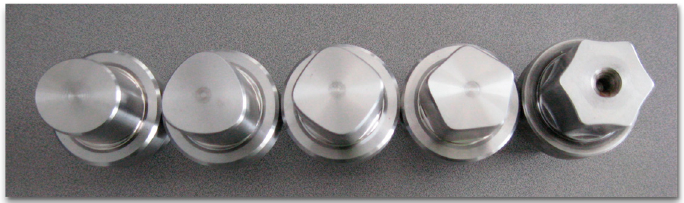
Figure 2. Some H-profiles manufactured by two-spindle process, Iprotec GmbH, © Guido Kochsiek, www.iprotec.de, Zwiesel, Germany [5].